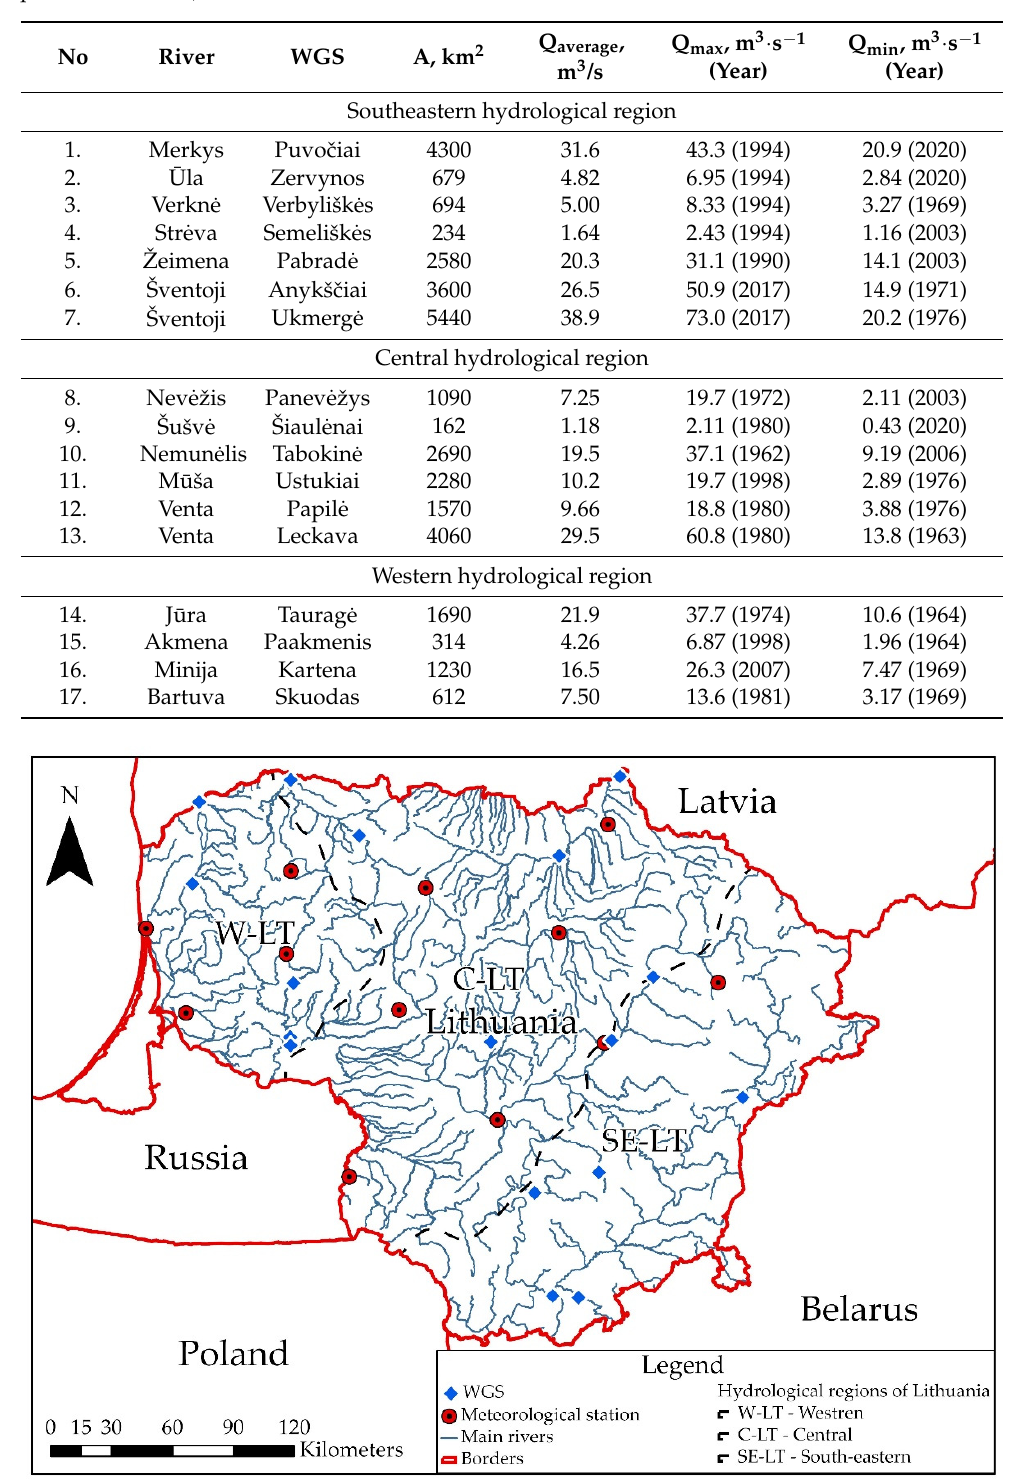
Figure 1. Location of hydrological regions and selected WGSs and MSs. Table 1. List of the studied gauging station catchments with the main characteristics (observation period 1961–2020).